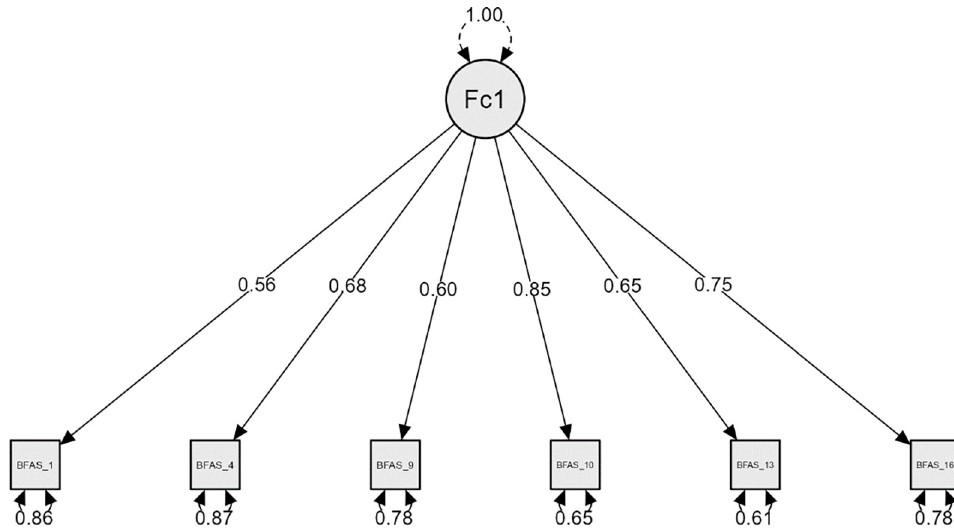
Fig 2. Model plot: BFAS single factor